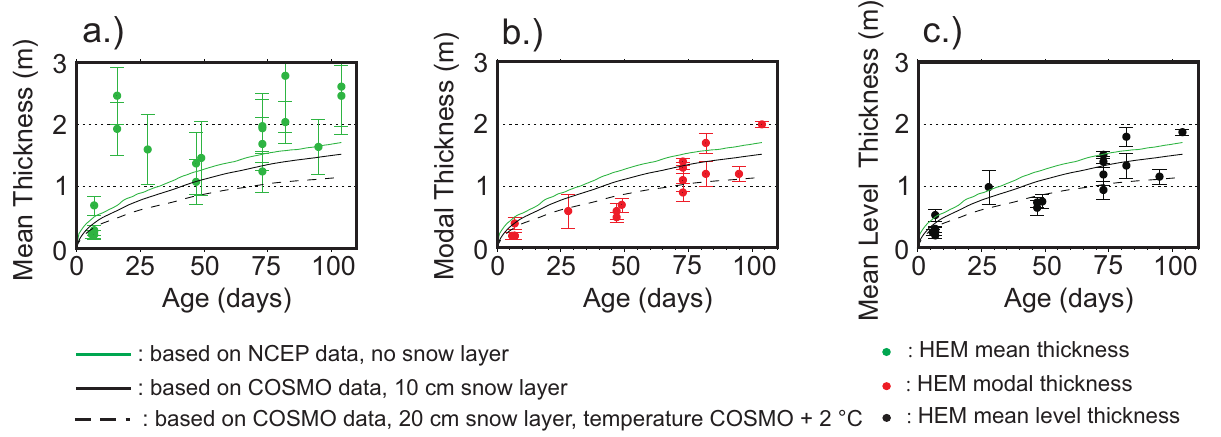
Fig. 9. Ice thickness versus age. Lines were calculated using a thermodynamic 1-D freezing-degree-day model based on Eq. (3) for one location in the survey area based on different air temperature data and snow thicknesses. (a) Comparison with mean-overall thicknesses (error bars show standard deviations within the corresponding HEM thickness profile). (b) Modal thicknesses (maxima of the histograms in Fig. 7). (c) Mean level ice thickness (similar to modal thicknesses in most cases). Error bars in (b) and (c) are standard deviations of level ice thickness within the corresponding HEM thickness profile.